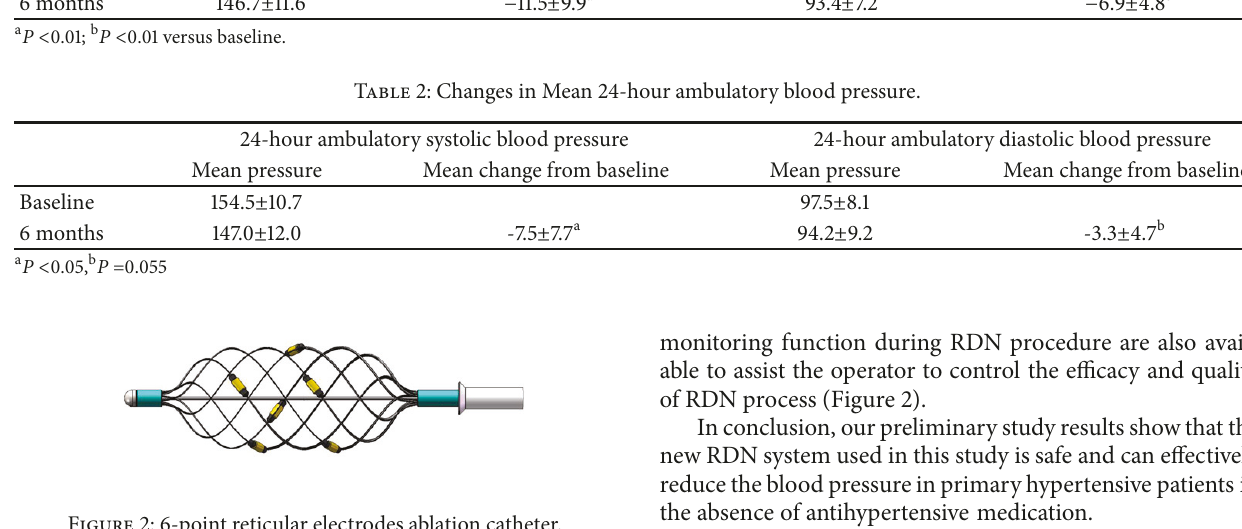
Figure 2: 6-point reticular electrodes ablation